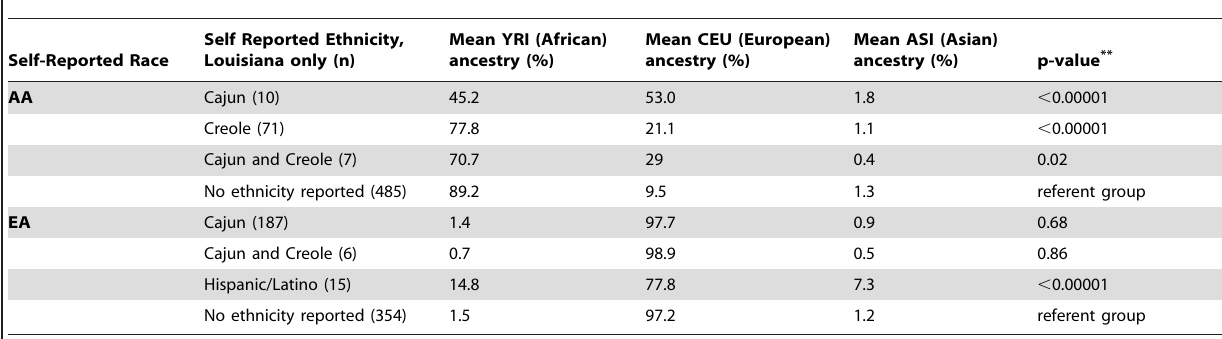
Table 2. Mean individual ancestry estimates by ethnicity for Louisiana only*.